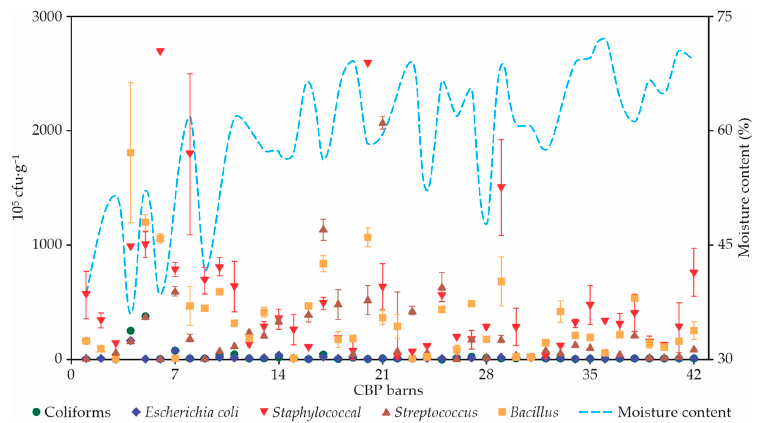
Figure 8. Bacterial analysis of bedding compost samples in 42 CBP